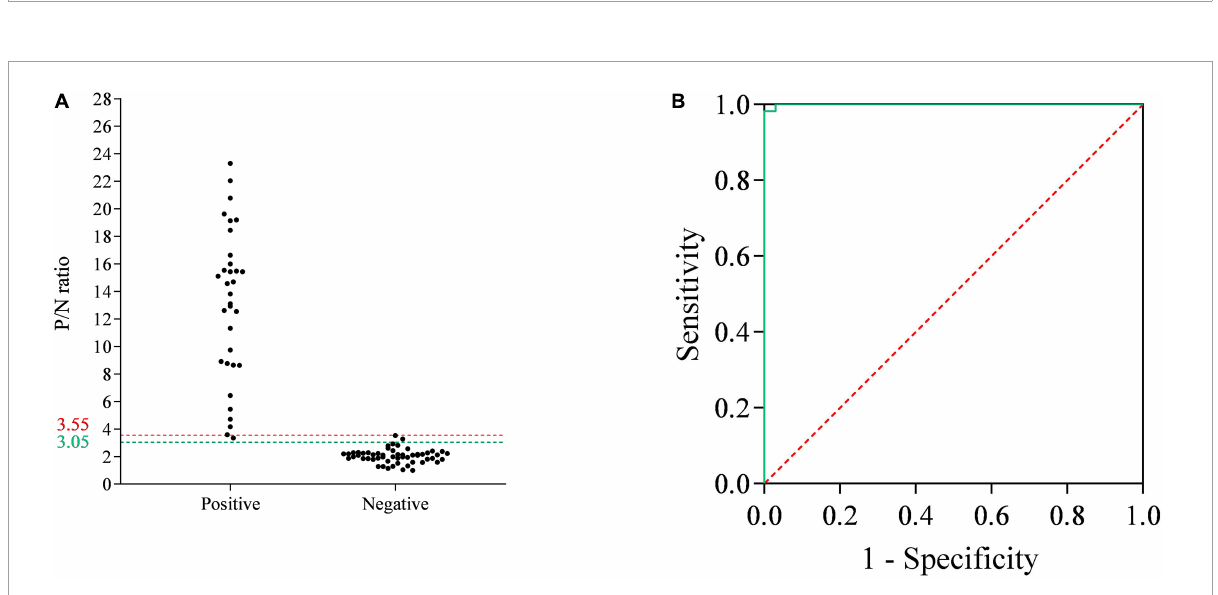
FIGURE4 The receiver operating characteristic (ROC) analysis of the p35-Luc LISA. (A) The serum samples that are determined as positive or negative by the commercial Ingezim p72-ELISA kit are evaluated by the p35-Luc LISA assay. The two horizontal lines delimit the doubtful p35-Luc LISA results (3.05/3.55). (B) ROC curve based on the data